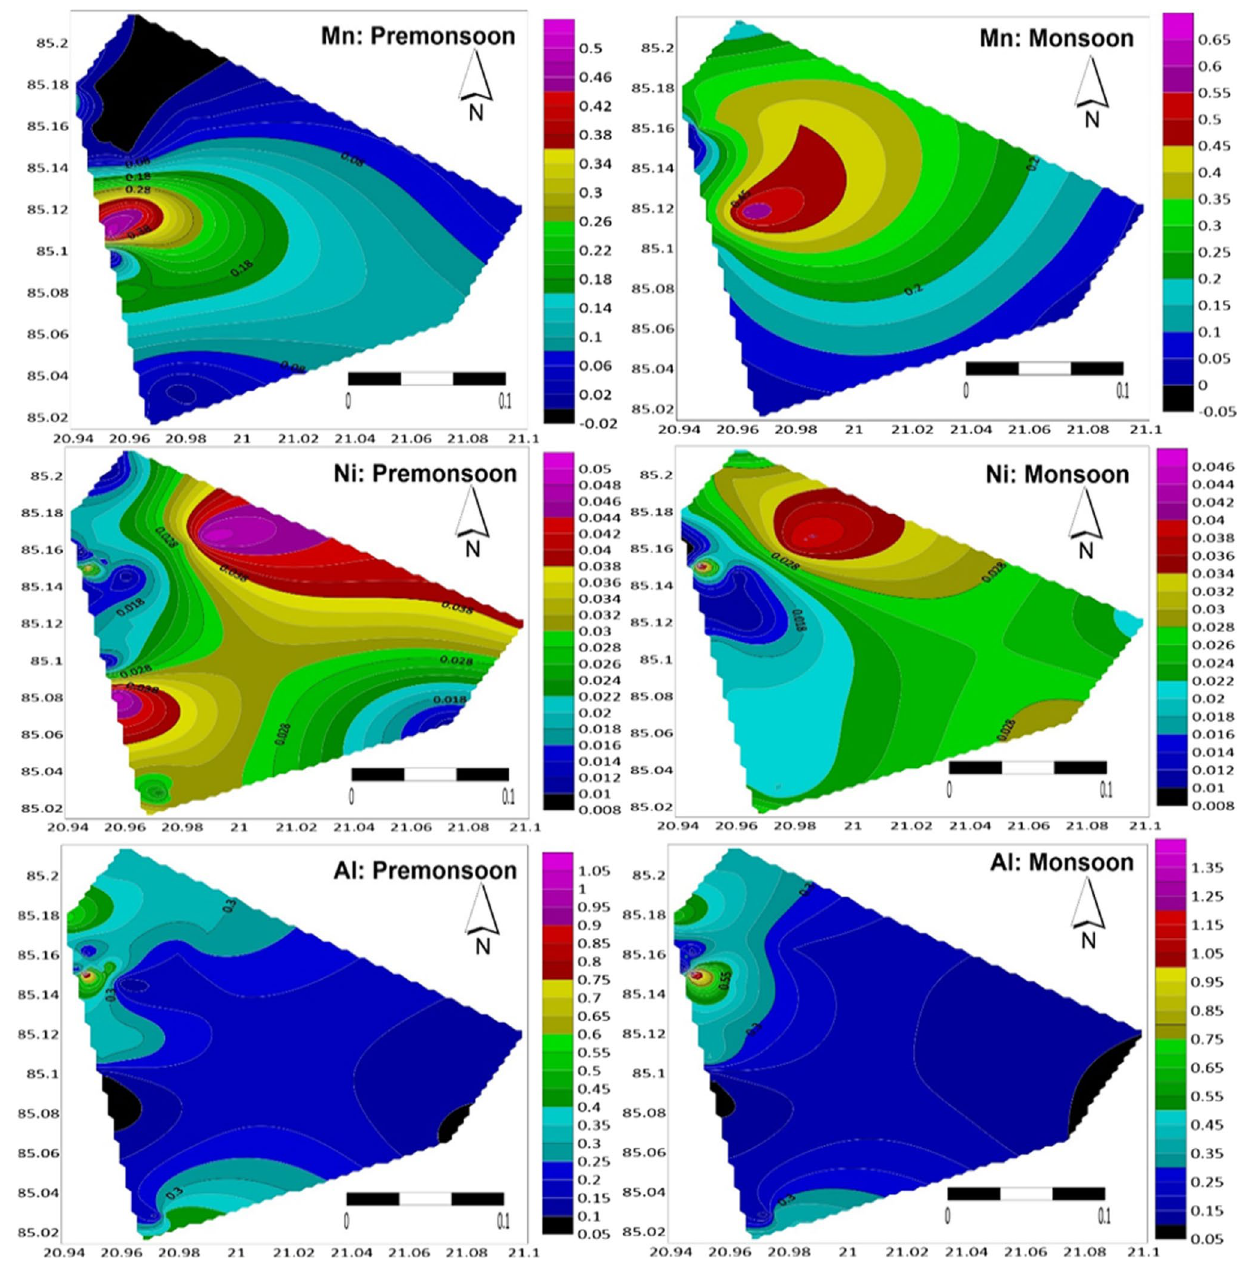
Fig. 4 Concentration contour map of Mn, Ni, Al in the water samples of Talcher coalfield during pre-monsoon and monsoon